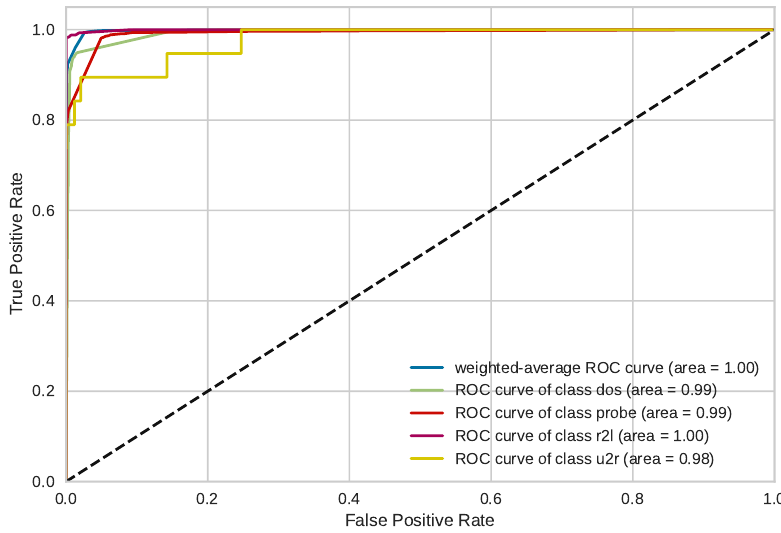
Figure 8. Computing the ROC curve by measuring the true-positive rate against the false-positive rate of the proposed model on each attack category (DOS, Probe, R2L, and U2R).